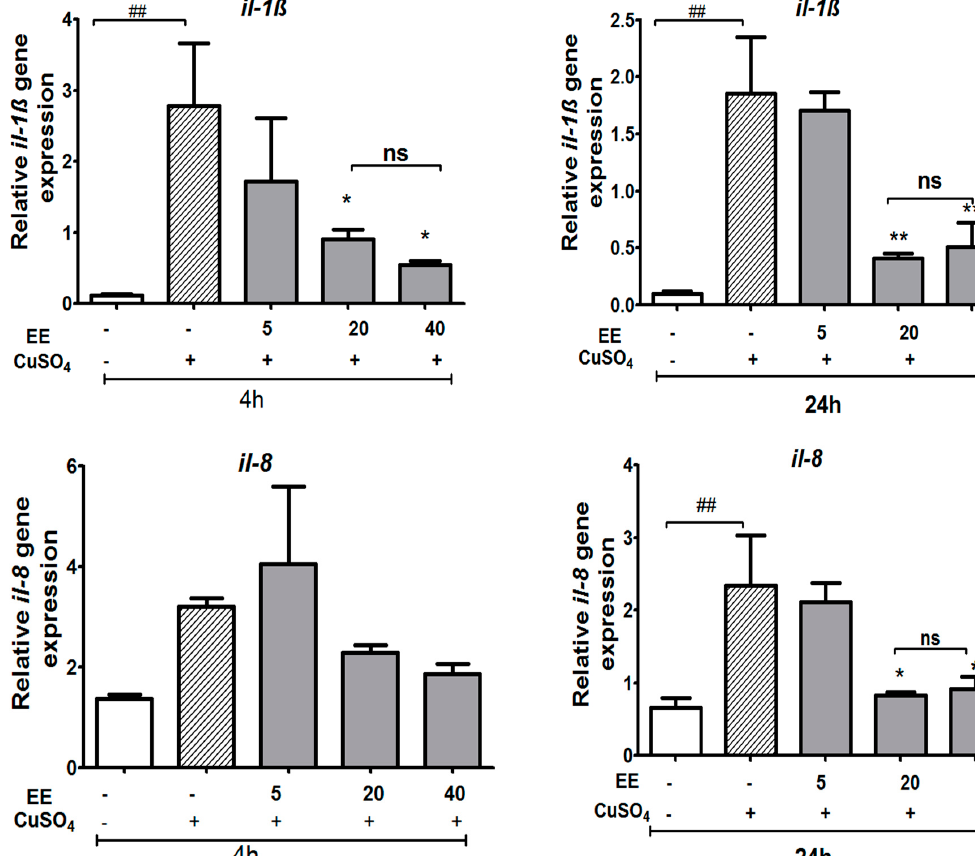
Table 1. Primer pairs used in this study.